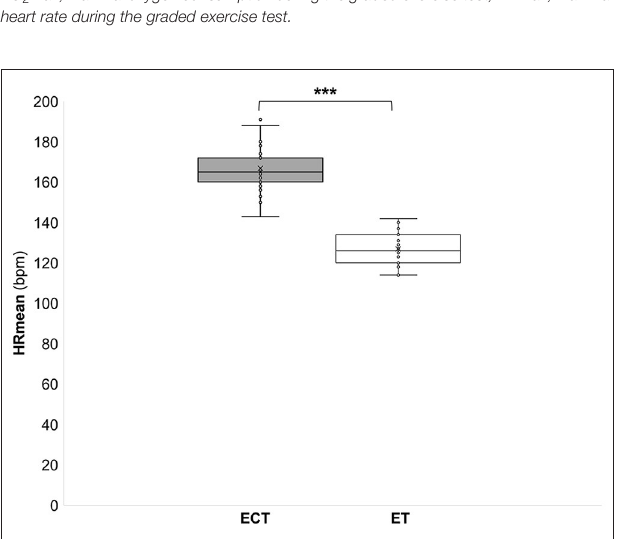
FIGURE 1 | Mean heart rate (HRmean) during a training in the ExerCube (ECT) and a moderate endurance training (ET) . *** p <